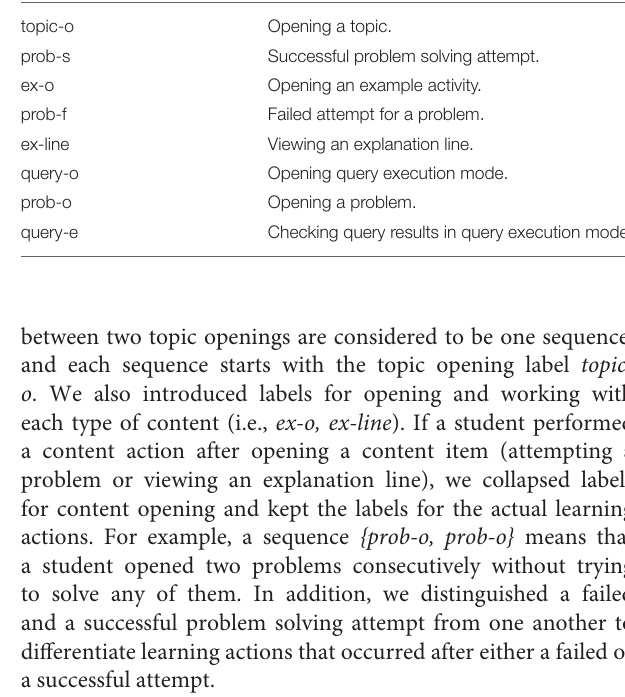
TABLE 2 | List of labels and the corresponding learning actions that were used in the labeling process. Pattern